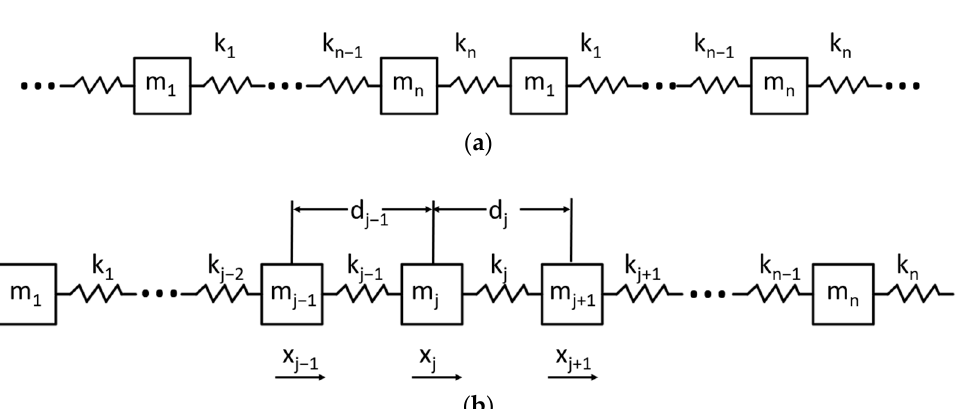
Figure 2. ( a ) Infinite Periodic Elastic Oscillator Structure ( b ) Single Period of Infinite Periodic Spring Oscillator Structure.